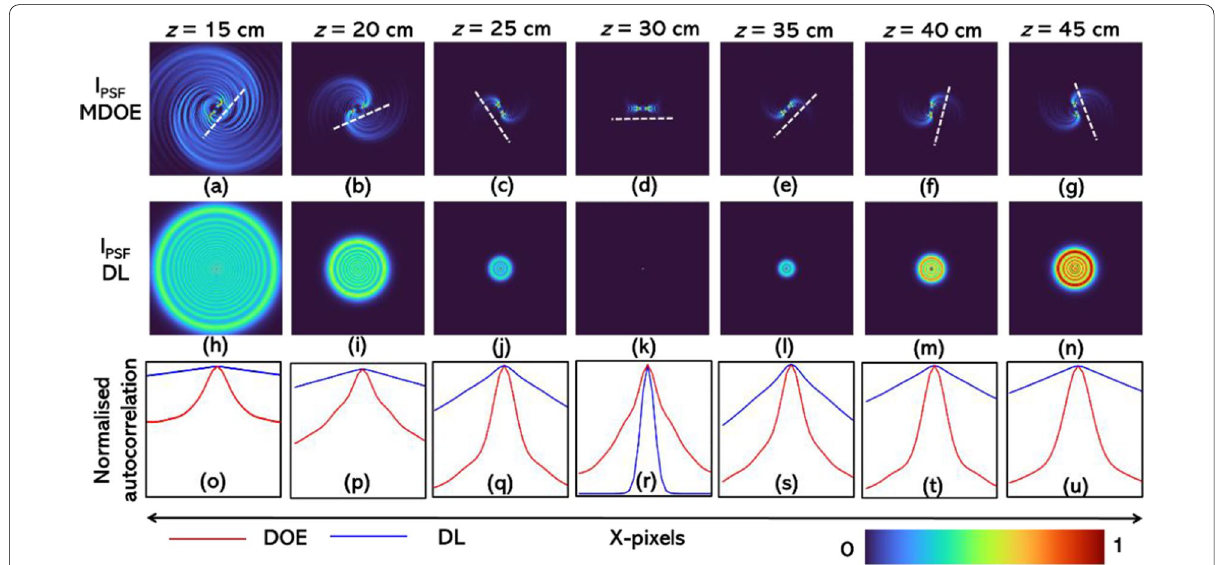
Fig. 2 Simulated intensity distributions generated by the MDOE for z a 15 cm, b 20 cm, c 25 cm, d 30 cm, e 35 cm, f 40 cm and g 45 cm. = Simulated intensity distributions generated by the DL for z h 15 cm, i 20 cm, j 25 cm, k 30 cm, l 35 cm, m 40 cm and n 45 cm. The white broken = line is attached to ( a – g ) to indicate the rotation angle of the spiral beam. The cross-section of the autocorrelation of the intensity distributions ( a – n ) are compared in ( o – u ), where blue is for DL and red is for